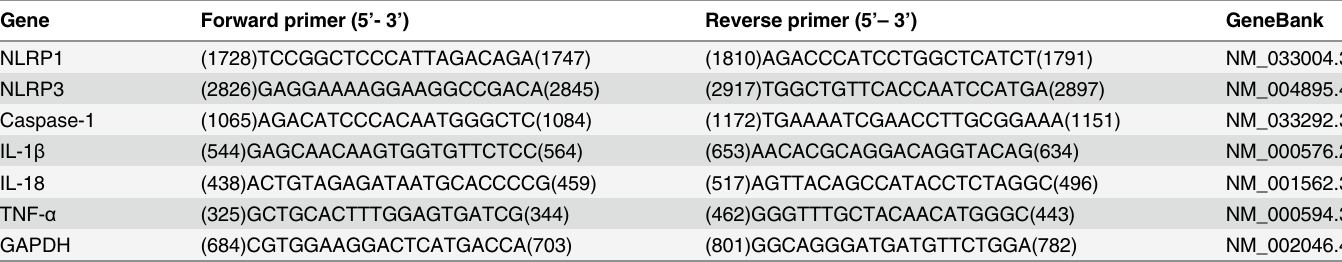
Table 1. Primers for inflammasomes proteins, cytokines and